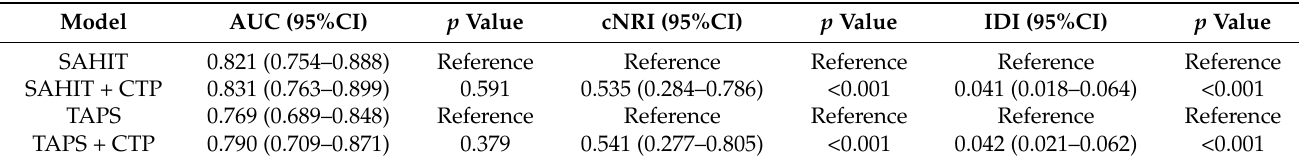
Table 4. Performance of previous models after the addition of the CTP